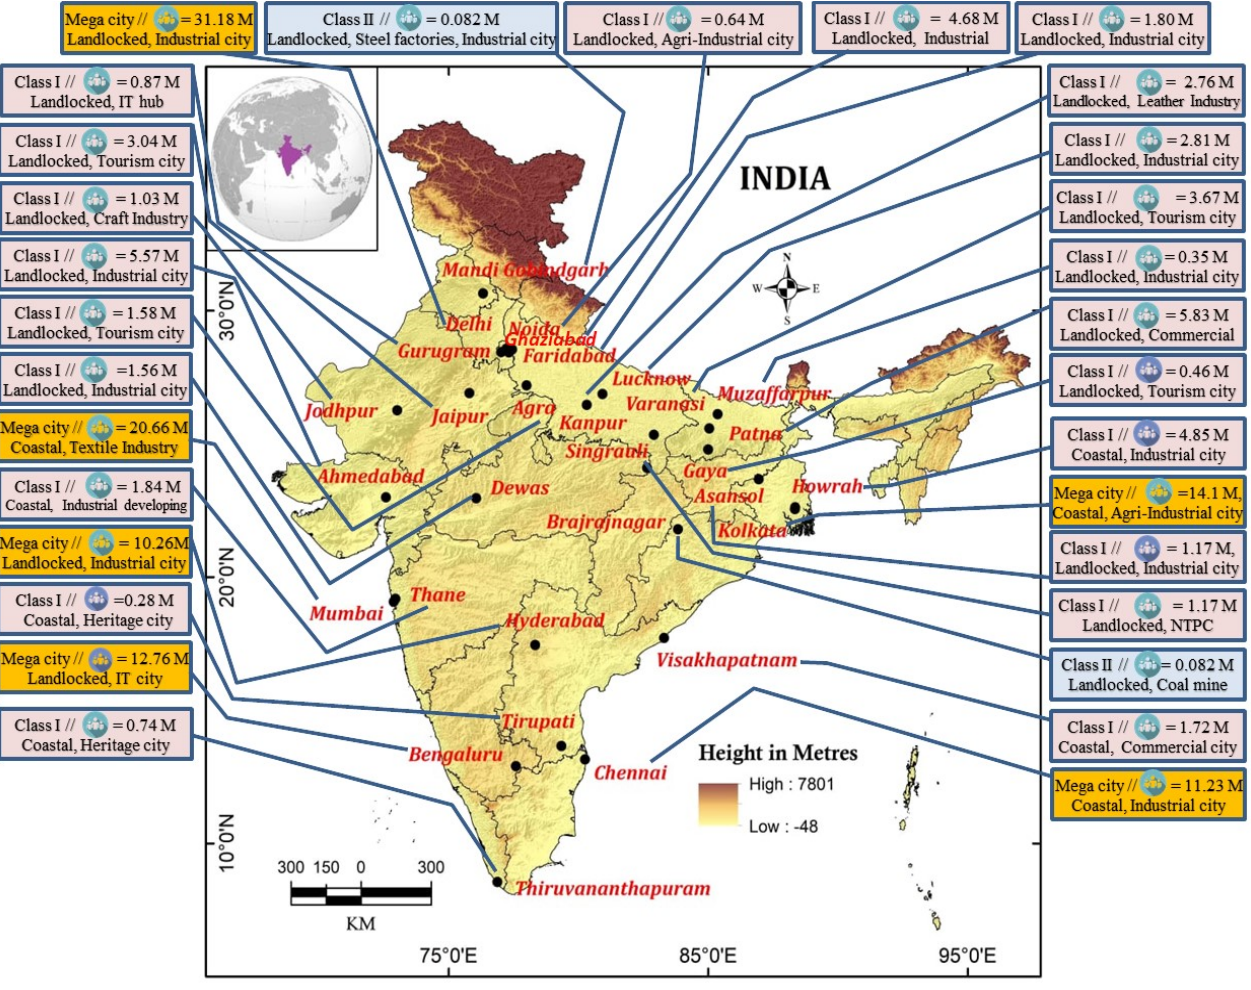
phase/pre-lockdown (17 January to 24 March 2020) and (ii) second phase/lockdown